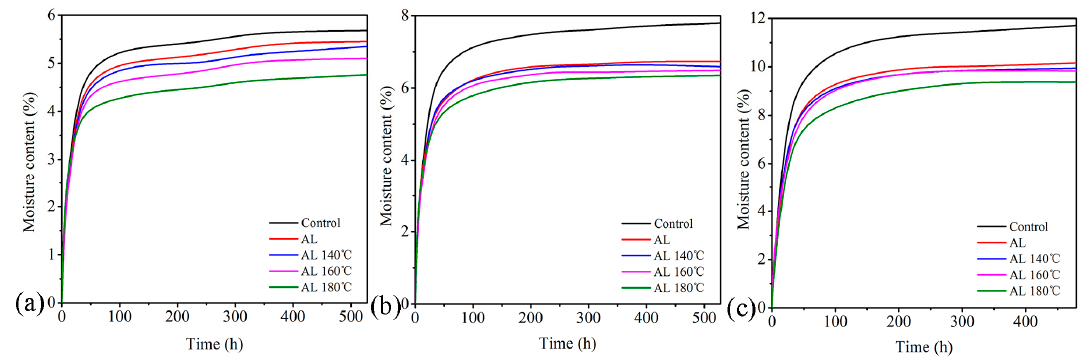
Figure 6. Moisture adsorption processes under ( a ) 45% relative humidity (RH), ( b ) 55% RH, and ( c ) 72% RH at 25 °C for the samples.